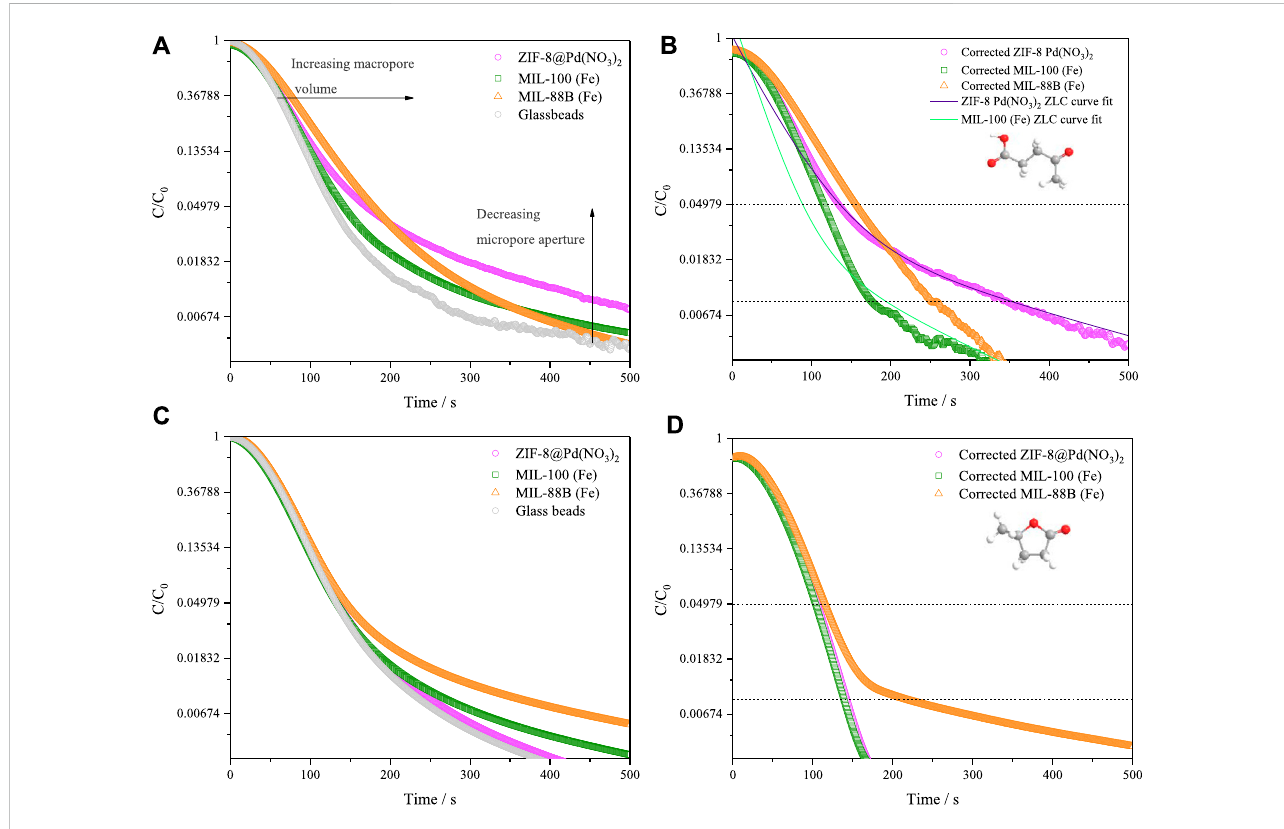
FIGURE 7 Liquid phaseZLC desorption curves forcatalysts inIPA,shown for .5 mL min -1 at80 ° C (A) levulinicacid, (B) levulinic acid corrected for sample geometry, (C) γ -valerolactone (D) γ -valerolactone corrected for sample geometry.